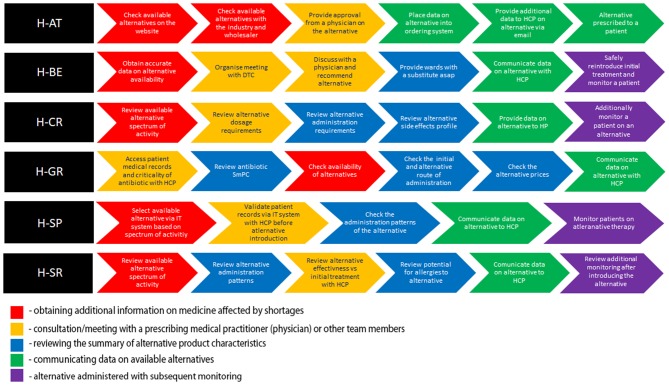
Color-coded flowchart highlighting similar patterns in sub-processes across health-care failure mode and effect analysis (HFMEA) study hospitals.